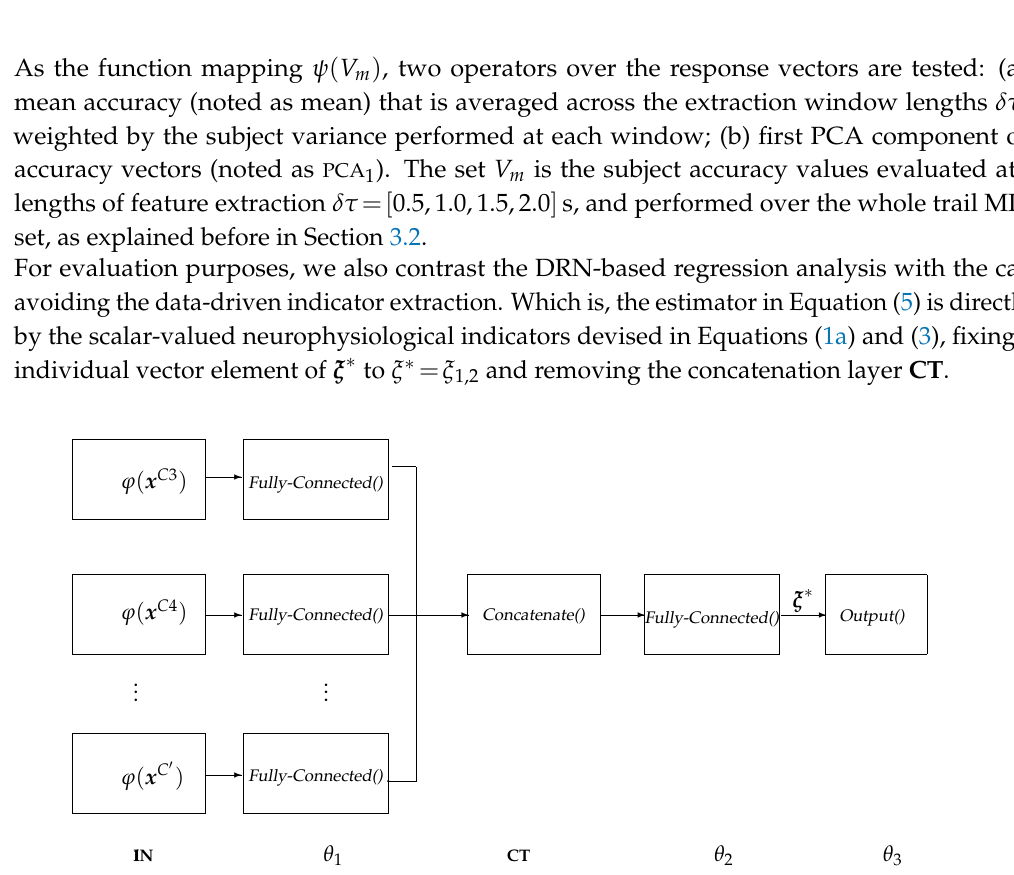
Figure 1. Proposed Deep Regression Network with three-layers architecture corresponding to the extraction of salient sensorimotor patterns, subject indicator computation, and the linear regression of performance responses on the assessed indicator